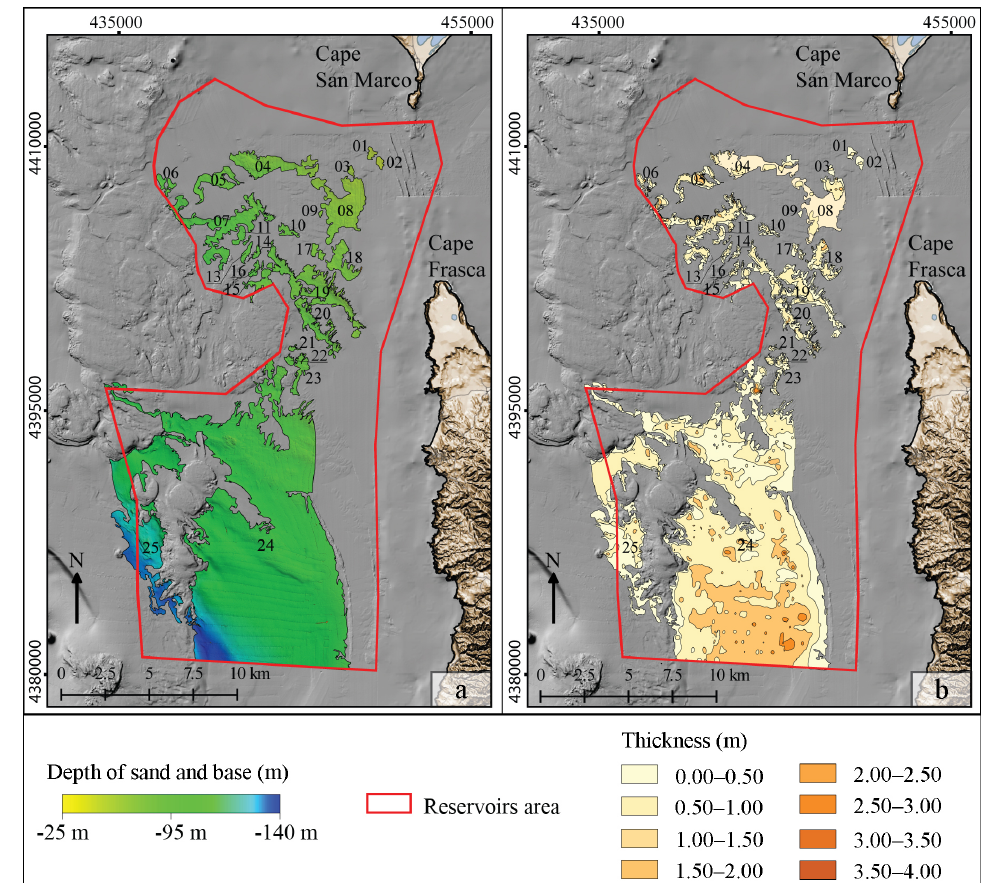
Figure 5. (a) Digital terrain model of the sand base; (b) thickness map of submerged sand deposits